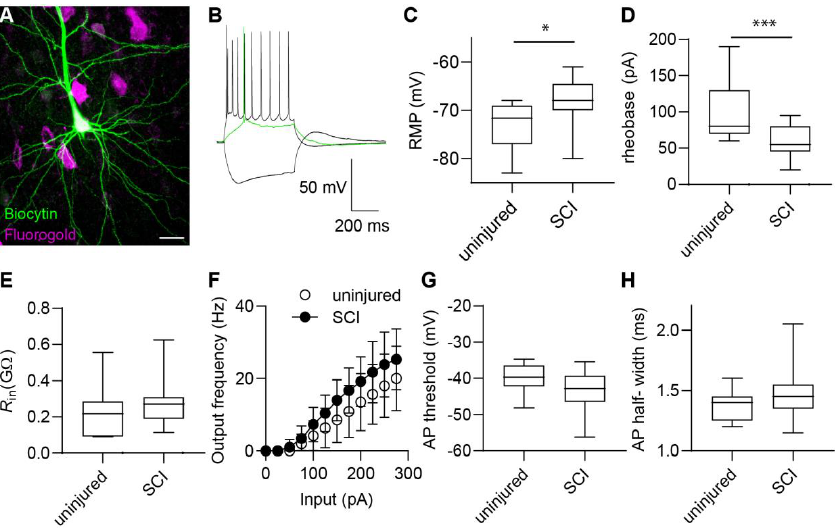
Figure 1. Increased excitability in M1LV neurons after SCI. ( A ) Morphology of M1LV neuron displayed by biocytin dialysis during patch-clamp experiments and streptavidin staining post-fixation (green). Fluorogold injected in the spinal cord at the time of injury (magenta) highlights axotomized M1LV neurons by retrograde labeling (co-labeling appears in white). ( B ) Typical AP firing pattern elicited in M1LV neurons upon chronic depolarization. Green trace highlights AP firing at rheobase. ( C ) The resting membrane potential (RMP) in M1LV neurons is depolarized significantly after SCI. ( D ) Rheobase in M1LV neurons is decreased significantly after SCI. ( E – H ) Input resistance (R in ) ( E ), relation of input (current) amplitude, and output (AP) frequency ( F ), AP threshold ( G ), and AP half-width ( H ) are not significantly altered in M1LV neurons after SCI. * p < 0.05; *** p < 0.001; scale bar = 20 µm.